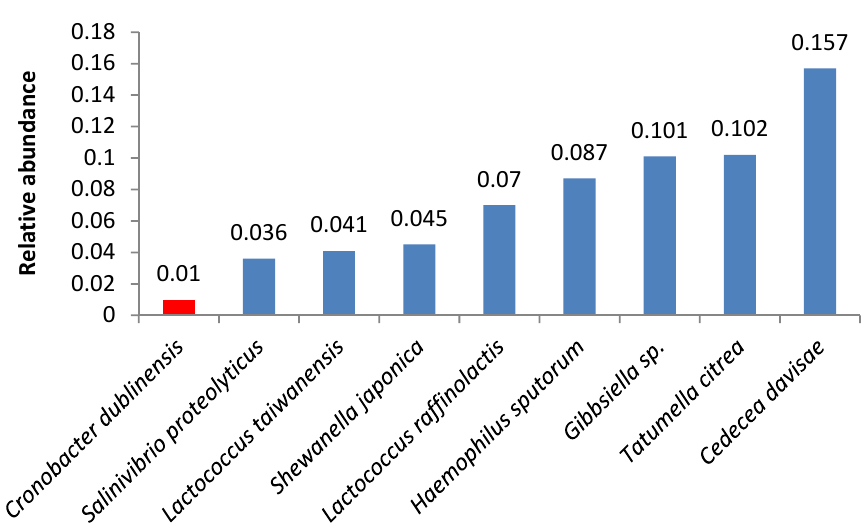
Figure 5. Relative abundance of amplicon sequence variants in butter sample no. 8.